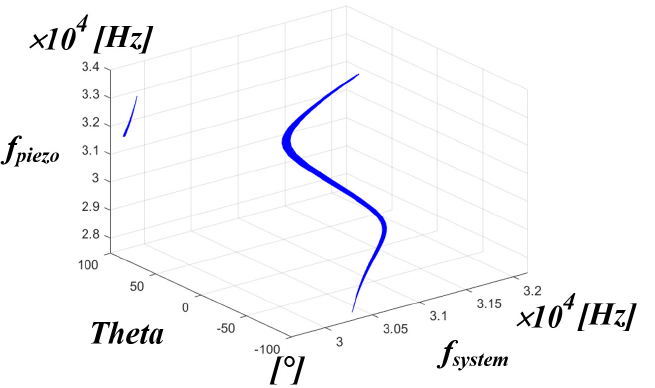
Figure 18. The 3D simulation result of f system , inverter phase difference theta, and f piezo